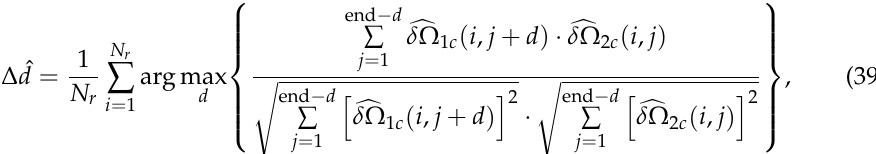
where ‘:’ represents the indexing range, ‘end’ is the sampled number of one of the matrix dimension, ⊕ indicates the ‘end-to-end’ splicing along the azimuth orientation, ∆ d is the sampled number with regard to ∆ D , and β 1 , β 2 are the weighing factors for the overlapped region in order to give a buffer to avoid discontinuity around the splice place, and to confirm the smooth splicing (they have a tendency depicted as Figure 7 for the splicing continuity). In reality, the PS altitude is unknown and therefore ∆ D cannot be straightly acquired by (31). Instead, ∆ d can be estimated by maximizing a correlation function and presented as